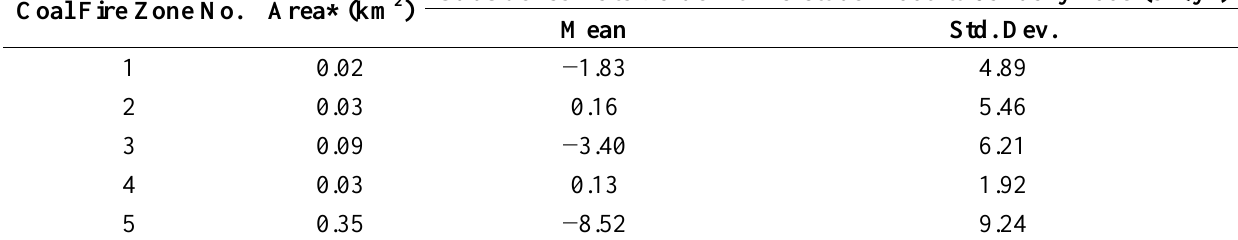
Table 2. Statistics of LOS subsidence rate values derived by the DInSAR technique in each coal fire zone of the Wuda coalfield. (1) *The areas of coal fire zones were calculated from the coal fire data that were obtained in the 2008 field campaign [24]. (2) A negative sign for deformation rate indicates an increasing distance from the satellite with time, whereas a positive sign indicates a decreasing distance from the satellite with time. (3) Submillimeter levels in Table 2 are only results of statistical computing, and do not representing the measurement accuracy of the